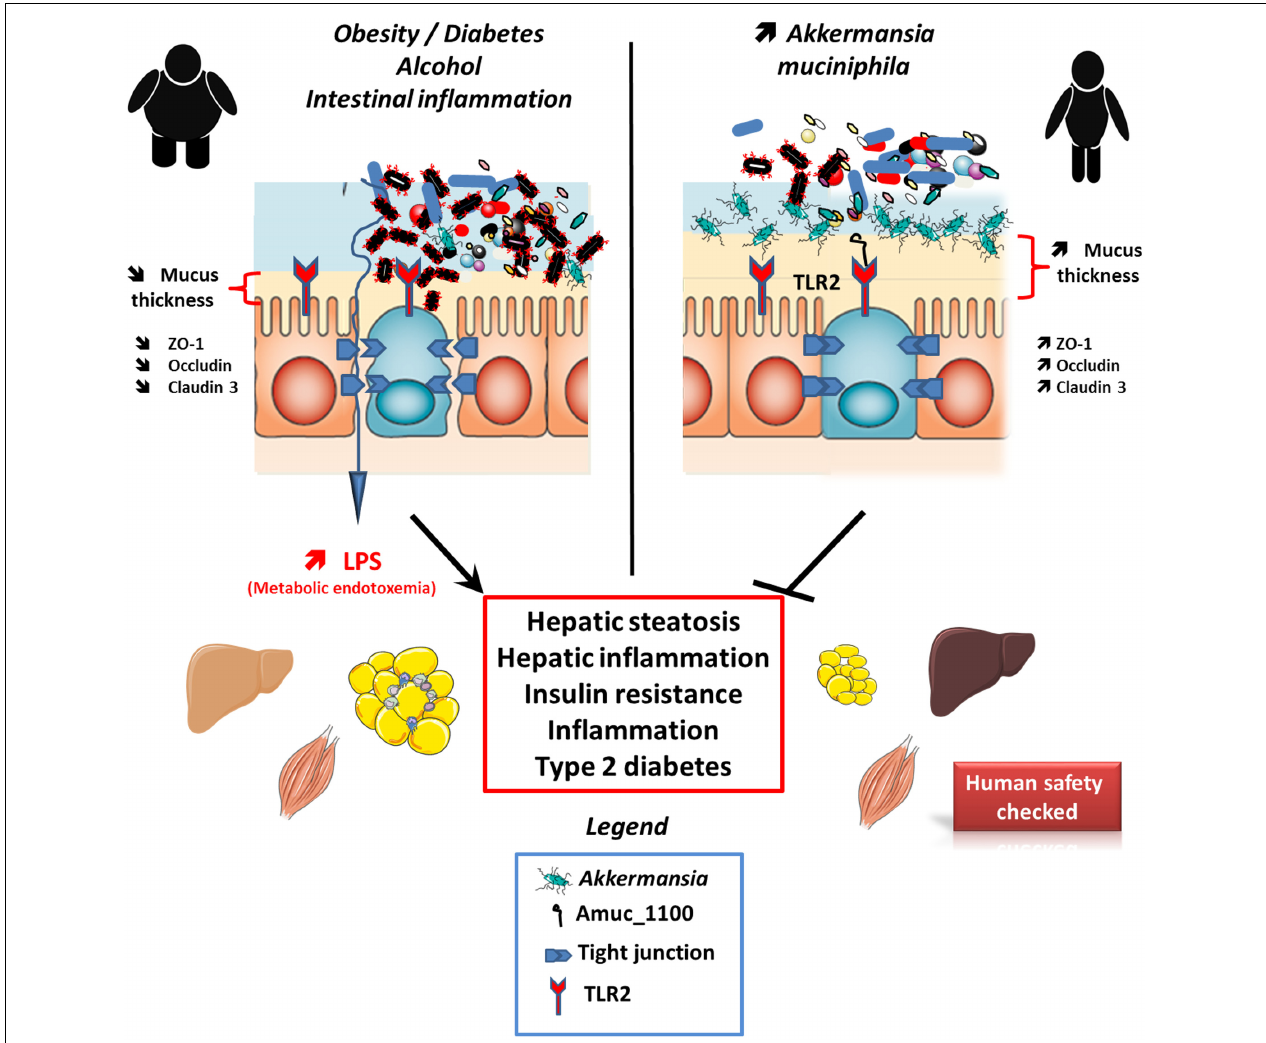
FIGURE 1 | Effects of A. muciniphila and derived products on host metabolism. A. muciniphila has been found to be lower in several conditions such as during obesity, diabetes, intestinal inflammation, liver diseases, or chronic alcohol consumption. This is associated with an altered gut barrier function leading to an increased plasma LPS levels and eventually triggering low grade inflammation and metabolic disorders. A. muciniphila alive or pasteurized as well as Amuc_1100 has been shown to restore gut barrier function likely by acting on TLR2 and restoring appropriate tight junction expression. All these results are associated with an increased mucus later thickness and an improvement of metabolic disorders. It is worth noting that an exploratory human investigation has shown that A. muciniphila is apparently